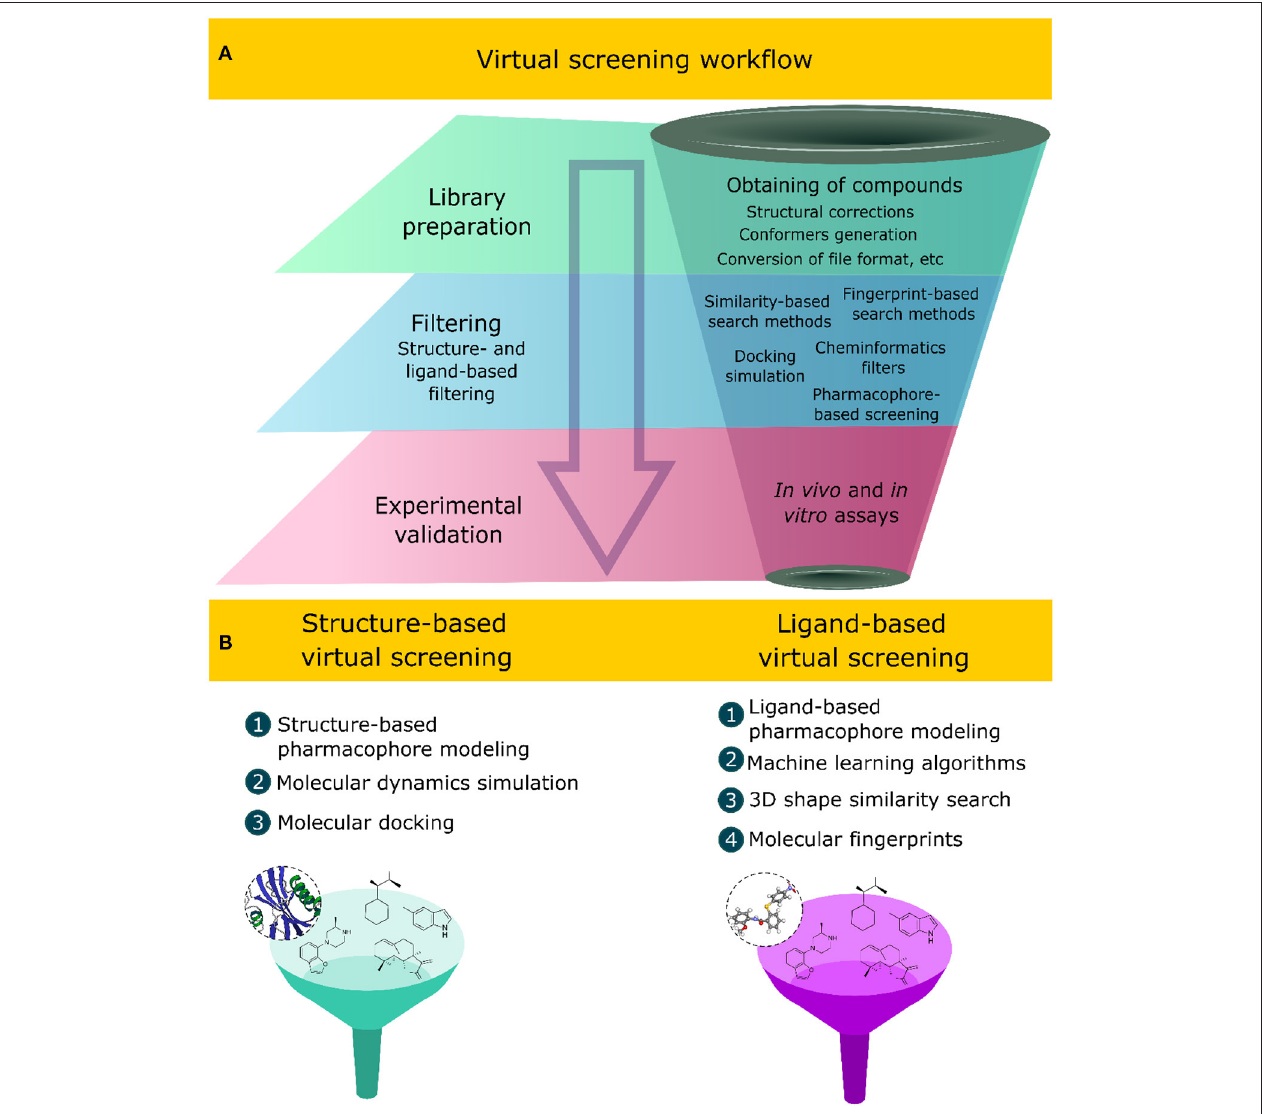
FIGURE 1 | (A) Sequential steps applied in virtual screening workflows to select bioactive natural products. (B) Ligand- and structure-based virtual screening approaches and some of their associated computational